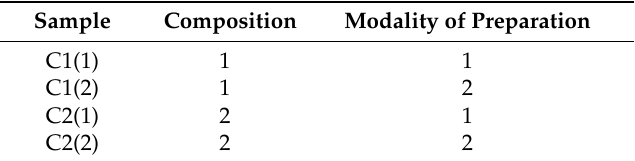
Table 2. Identification of the four samples in relation to the composition and modality of preparation.